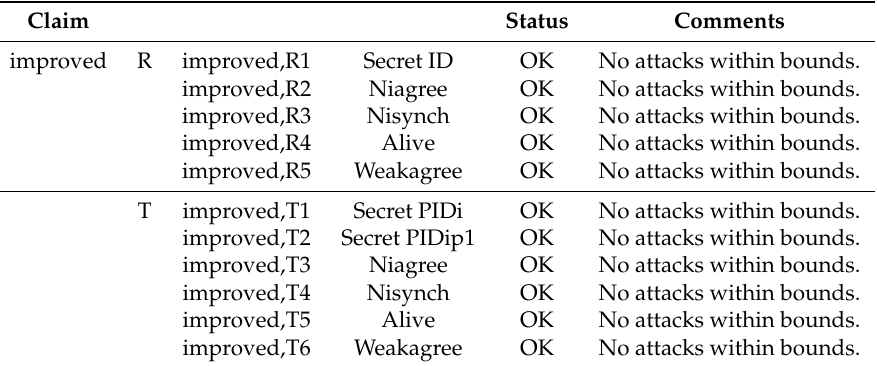
Table 2. The proposed protocol verification results using the Scyther tool.